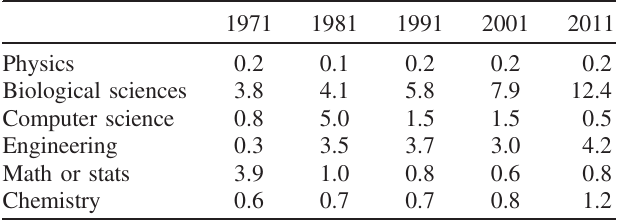
TABLE I. Percentage of women intending to major in STEM fields, selected years. Note that in all years the proportion of women intending to major in physics is significantly different from the proportion selecting each of the other STEM majors.